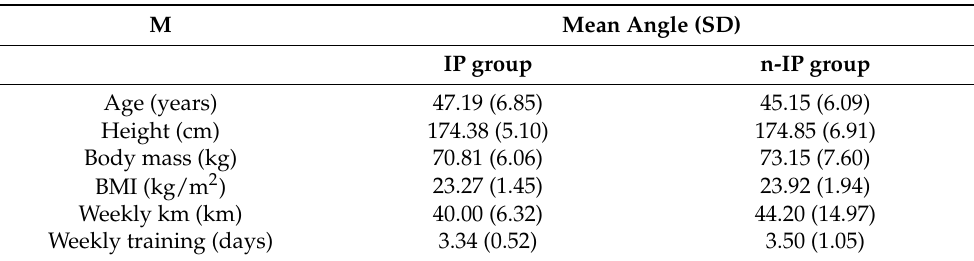
Table 1. Participants